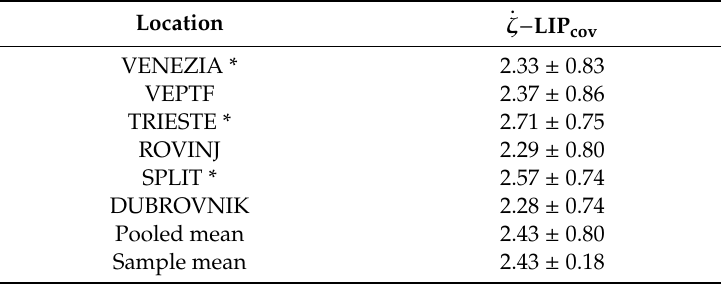
Table 8. Rates of absolute sea level change from TG records over whole record (1974–2018), corrected for VLM estimated with the LIP cov approach. All data are in mm y − 1